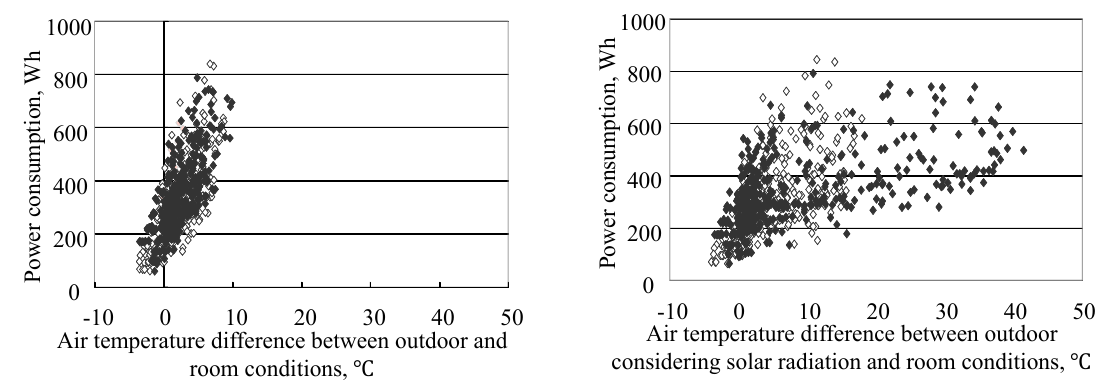
Figure 5. Hourly relationship between outdoor-to-room air temperature difference and cooling power consumption. black: Before painting; white: After painting; left : Air temperature difference without considering solar radiation effect; right : Air temperature difference considering solar radiation